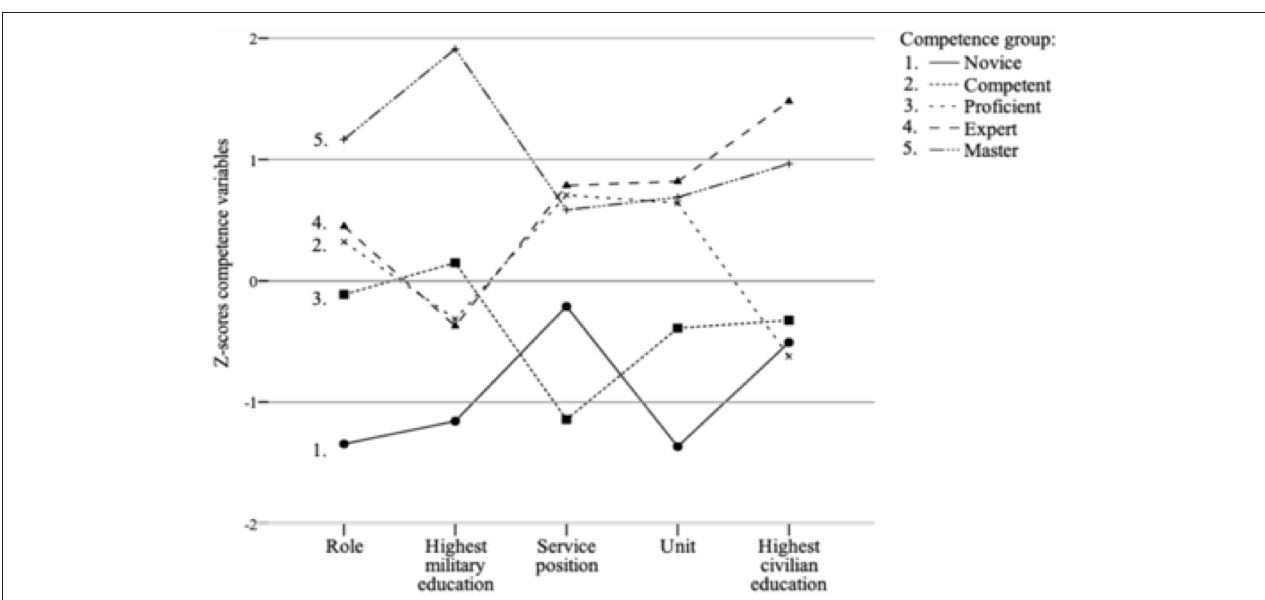
FIGURE 2 | Competence variables scores due the five competence groups (Z-scores). N = 917. Number of cases in each cluster: novice ( n = 107), competent ( n = 267), proficient ( n = 227), expert ( n = 171), master ( n =